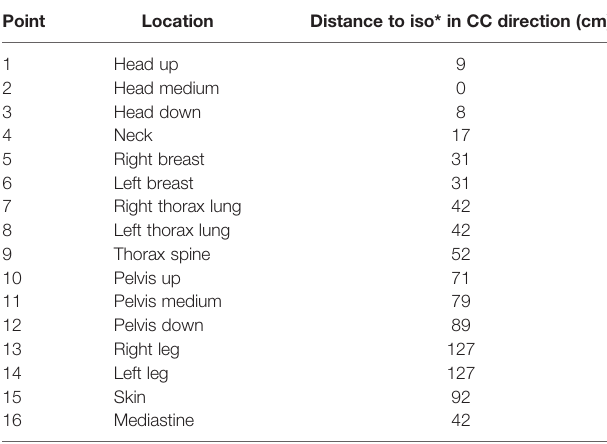
TABLE 1 | Points in NORMA phantom.